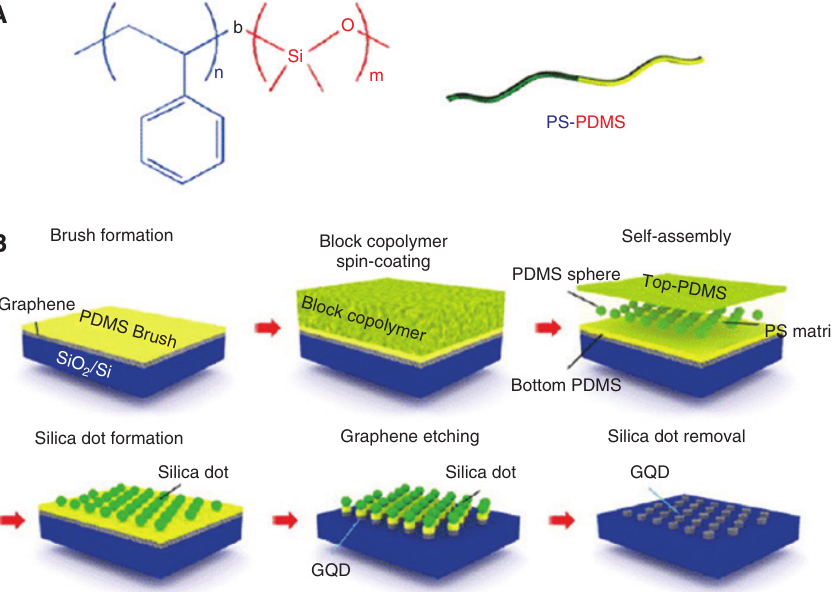
/Si substrate. (A) Chemical 2